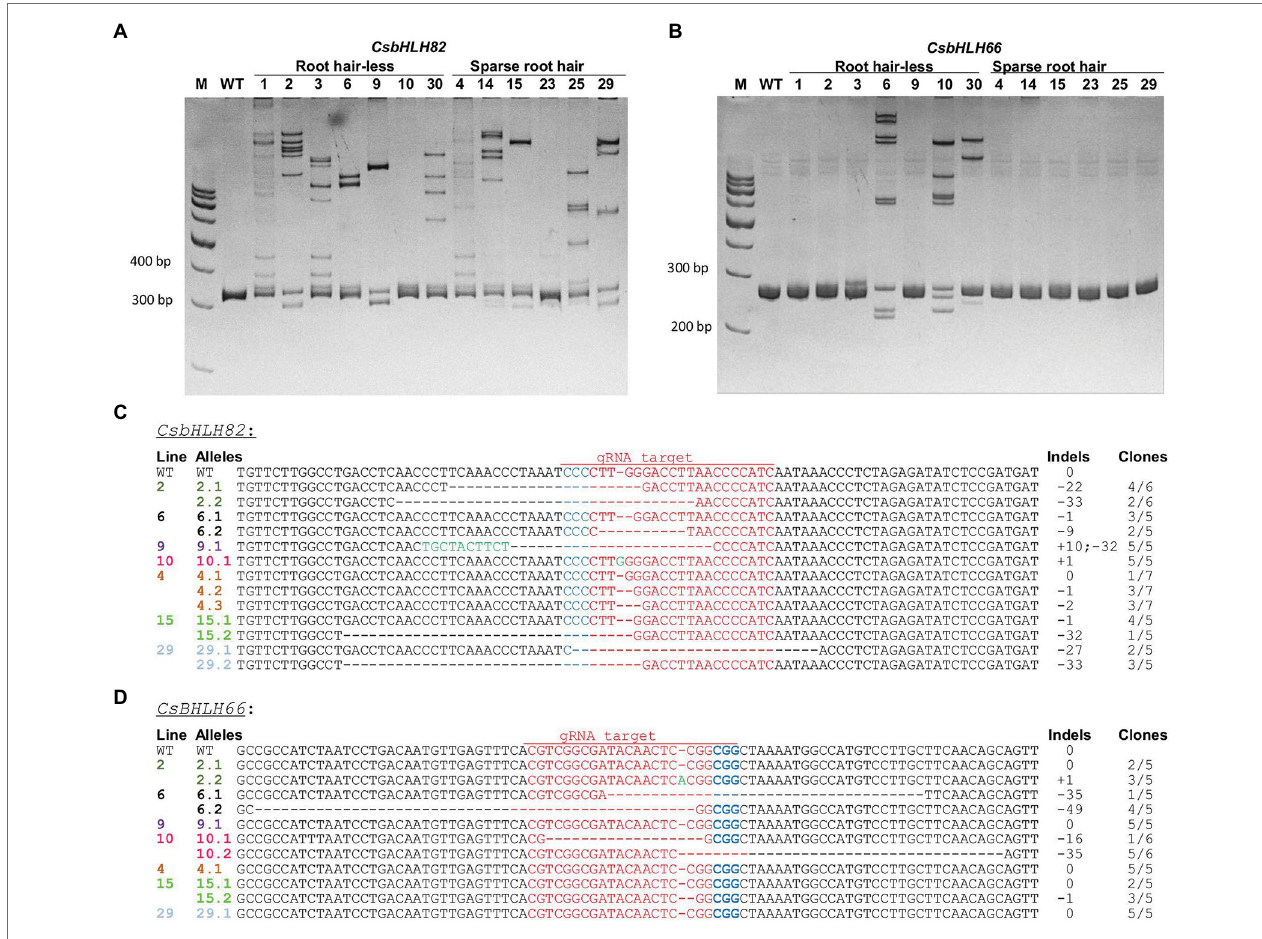
FIGURE 7 | Identification and characterization of induced mutations in cucumber hairy roots. (A,B) Heteroduplex analysis of CsbHLH82 and CsbHLH66 , respectively. M: 100 bp DNA Ladder; WT: wild type. (C,D) Expanding targeted sequences of CsbHLH82 and CsbHLH66 genes. Red letters indicate target sequences. Blue letters refer to PAM sequences. Green letters indicate inserted nucleotides. The indels indicate targeted sequence changes: 0 for no change, − for deletion, + for insertion. The number of clones used for sequencing was